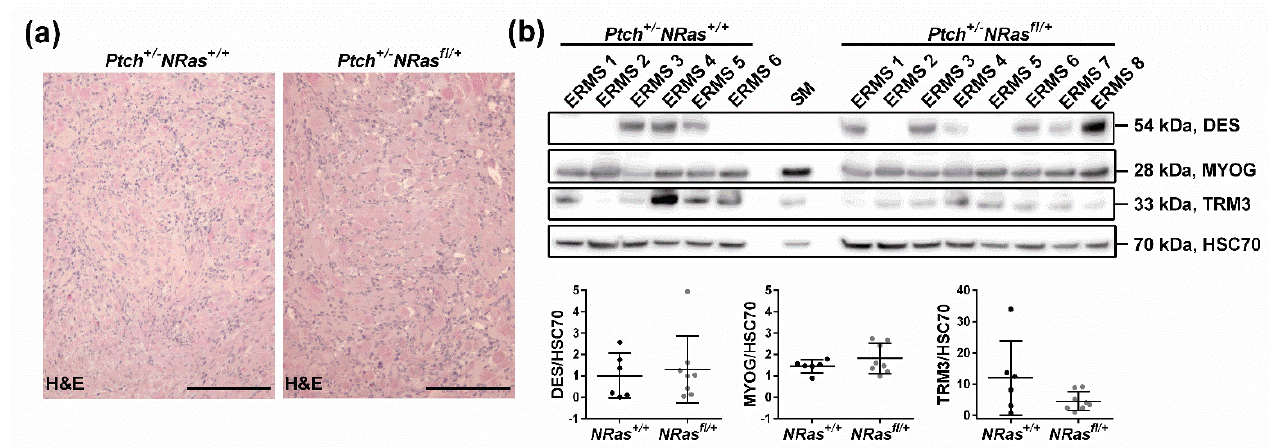
Figure 3. ( a ) Representative H&E staining of ERMS and ( b ) the expression of muscle differentiation markers in ERMS and normal skeletal muscle upon oncNRAS expression in 2-week-old mice. Representative Western blots analyses (top) and quantification of the results (bottom) of desmin (DES), myogenin (MYOG) and tropomyosin 3 (TRM3) expression in ERMS protein samples isolated from Ptch +/- NRas +/+ Myf5 CreER/wt ( Ptch +/- NRas +/+ ) and Ptch +/- NRas fl/+ Myf5 CreER/wt ( Ptch +/- NRas fl/+ ) mice, which had been injected with tamoxifen at the age of 2 weeks. HSC70 served as loading control. Bars: mean ± SD; dots: individual tumors. Statistical evaluation was conducted by Mann–Whitney testing. Scale bars in ( a ) 200 µm.